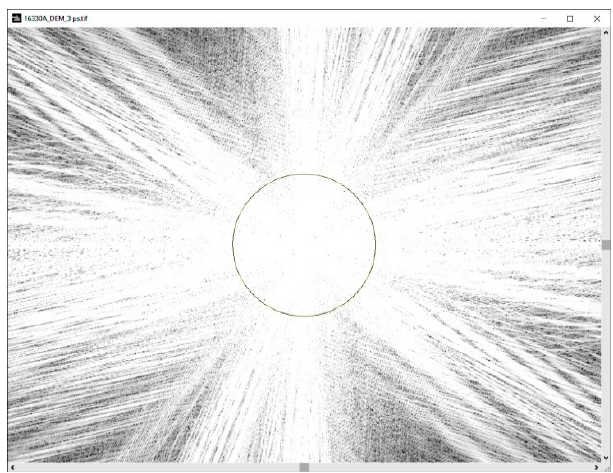
Figure 7. Fourier spectrum indicating a circle with a radius of 125 pixels used to delimit the low